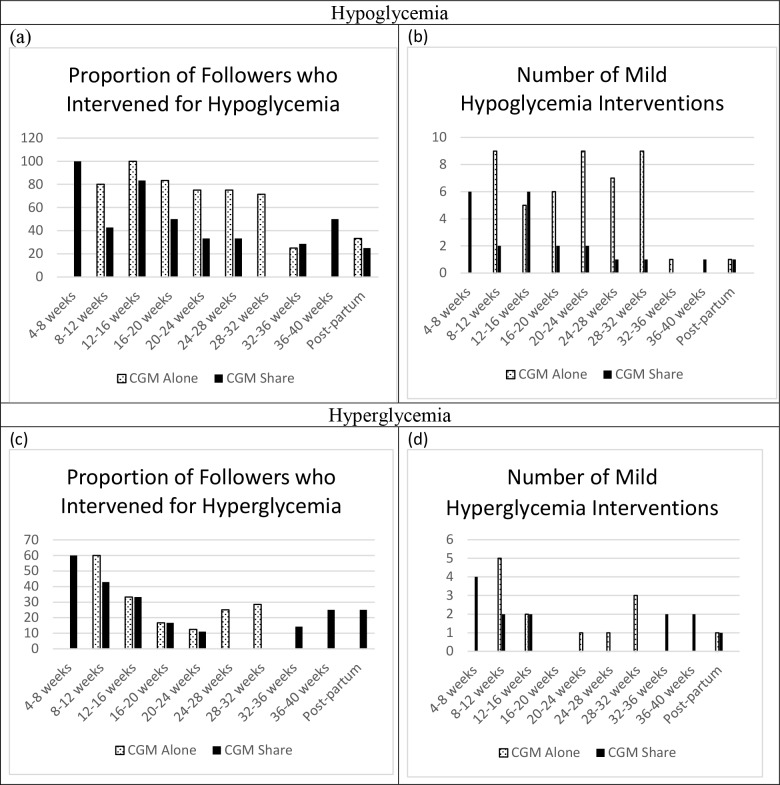
Absolute number of follower interventions.Fig 3A is the proportion of followers who intervened for hypoglycemia on behalf of their pregnant partners. Fig 3B is the number of mild hypoglycemic interventions performed by followers on behalf of their pregnant partners. Fig 3C is the proportion of followers who intervened for hyperglycemia on behalf of their pregnant partners. Fig 3D is the number of mild interventions for hyperglycemia performed by followers on behalf of their pregnant partners.